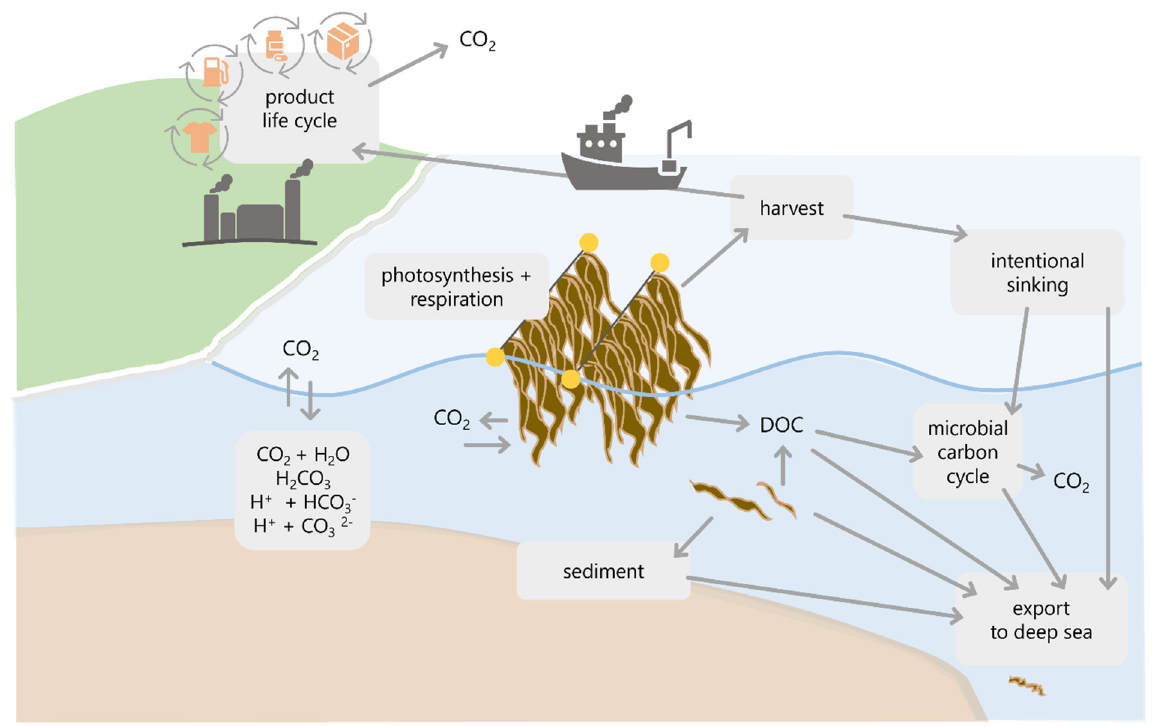
Figure 2. Simplified overview of the difficulties of assessing carbon permanence at macroalgae farms due to multiple connected carbon cycles, including CO 2 and dissolved organic carbon (DOC). Arrows represent the flow of carbon (in various states) throughout the life cycle of cultivated macroalgae.